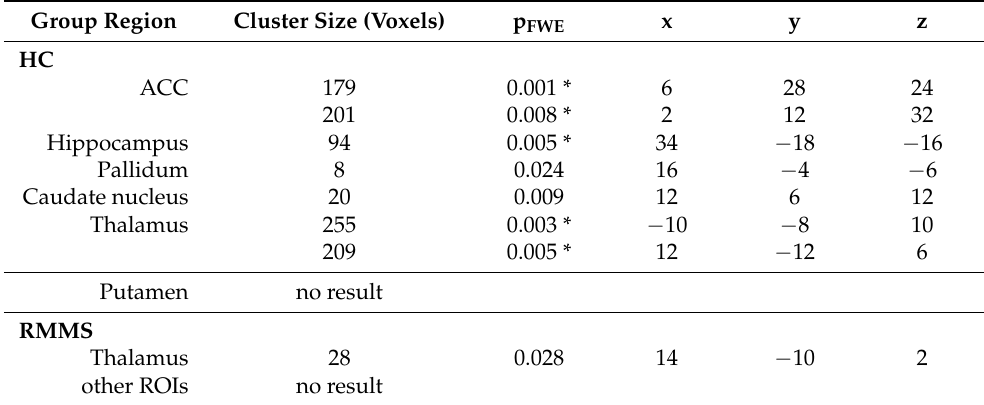
Table 4. Activation by ExecAttent in healthy controls (HC) and patients with RRMS (MS): Results of permutation tests using threshold-free cluster enhancement. Clusters containing only voxels with pFWE < 0.05 and their maximum with MNI coordinates are shown. Bonferroni threshold is pB =